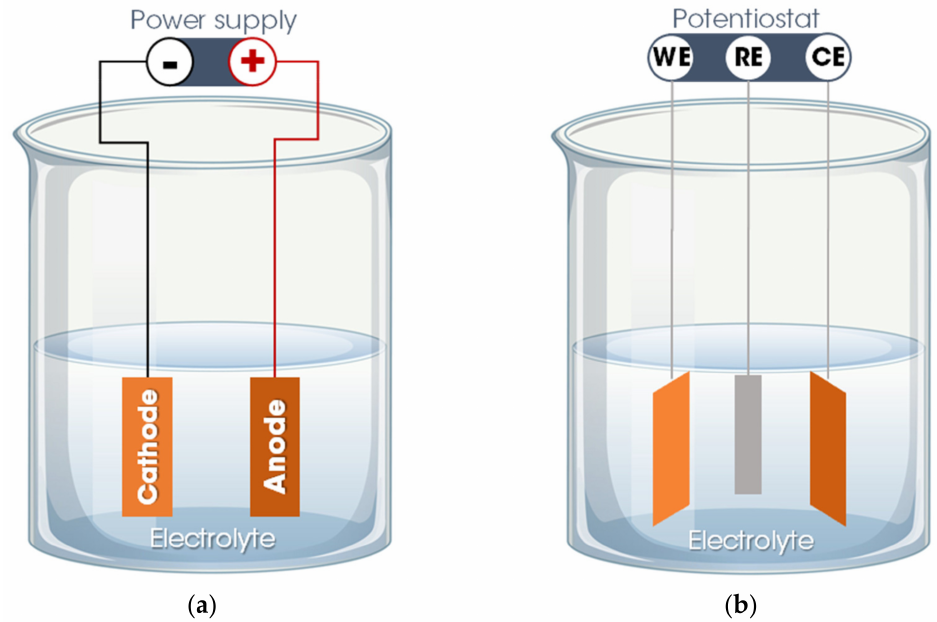
Figure 2. Electrodeposition system: ( a ) Two-electrode system for galvanostatic electrodeposition and ( b ) three-electrode sys- tem for potentiostatic electrodeposition. Legend: WE = working electrode; CE = counter electrode; RE = reference